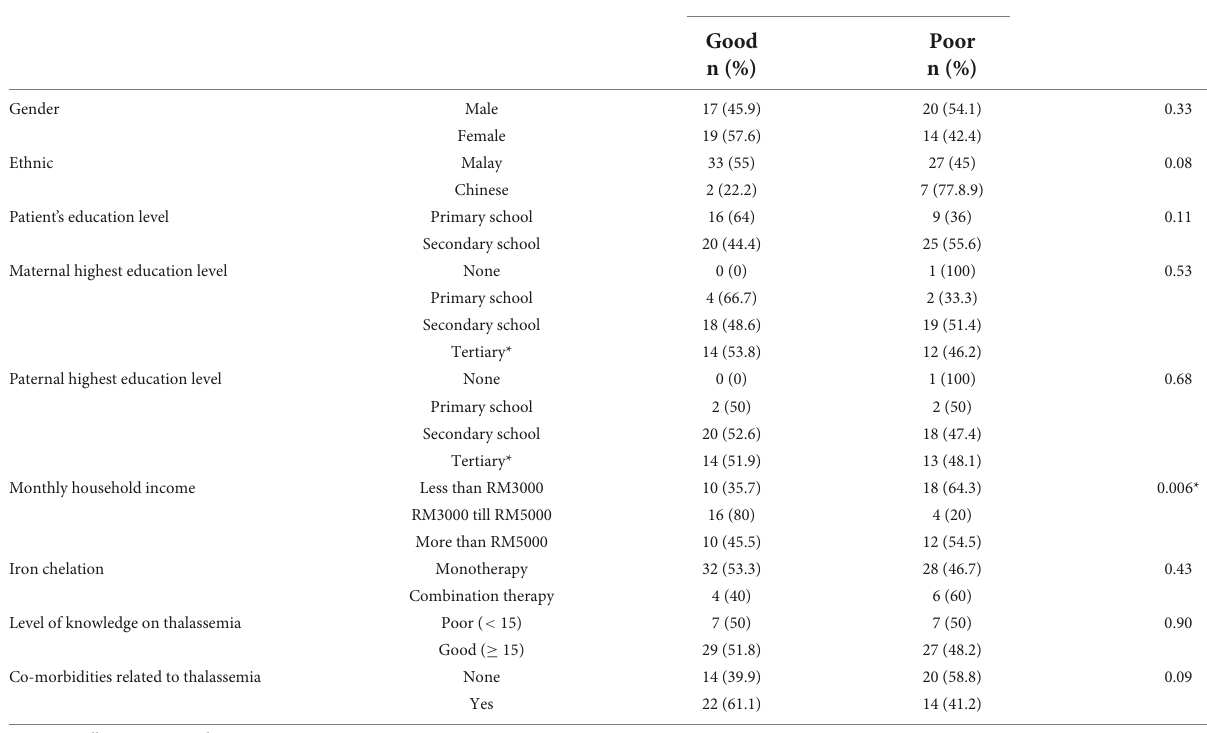
TABLE 3 Association of socio-demographic and clinical factors with level of adherence to iron chelation therapy amongst 70 thalassemia patients. Factors